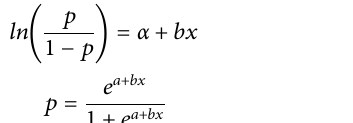
Table 1 . To fi nd that we use the MVP which is an appropriate method to analyze correlated multivariate binary outcomes.